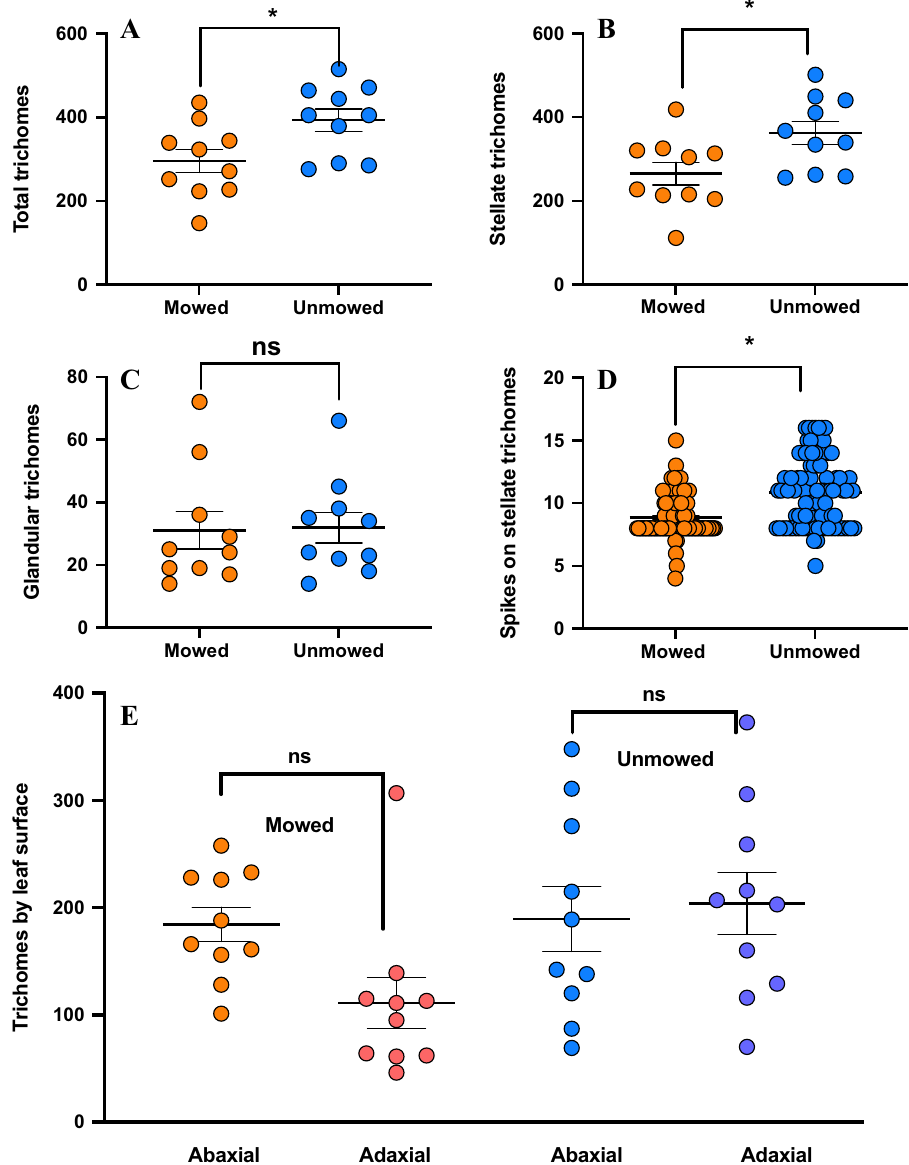
Figure 6. Results of leaf trichome density: ( A ) number of trichomes on leaves for mowed and unmowed treatments (Y-axis) ((Two sample T-test; t = − 2.53; P-value = 0.02), ( B ) compares mean number trichomes on abaxial and adaxial side of the leaf for both mowed (Y-axis) (Two-way Anova; F = 1.27; P-value = 0.26) and unmowed (Y-axis) (Two-way Anova; F = 3.50; P-value = 0.06) treatments respectively, ( C ) mean number of stellate trichomes on leaves for mowed and unmowed treatments (Y-axis) (Two sample T-test; t = − 2.47; P-value > 0.02), ( D ) mean number of glandular trichomes on leaves for mowed and unmowed treatments (Y-axis) (Two sample T-test; t = − 0.10; P-value = 0.918), ( E ) number of spikes on stellate trichomes for mowed and unmowed treatments (Y-axis) (Two sample T-test; t = − 6.26; P-value < 0.00). Means are shown by scale bars and asterisk denotes significantly different results at P < 0.05, while ns denotes non-significant